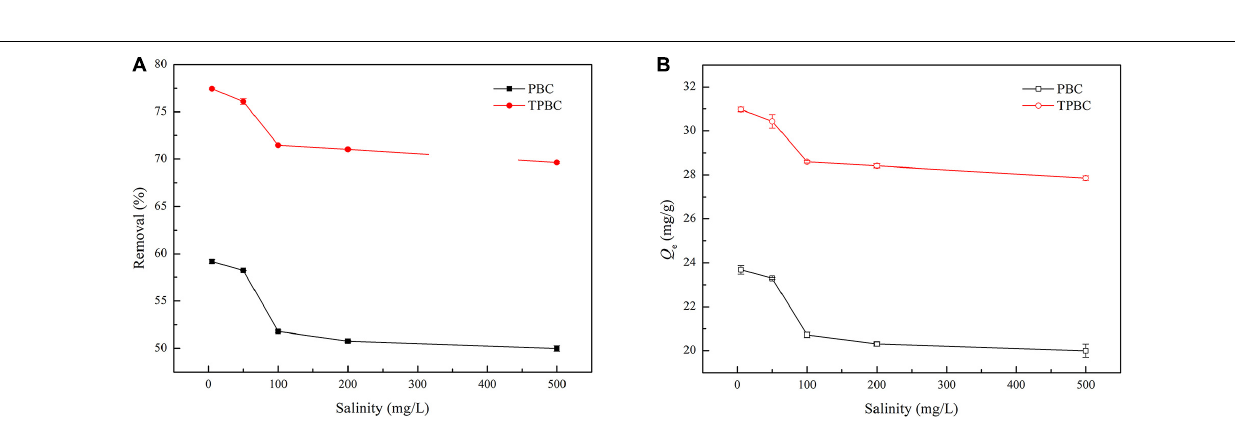
Frontiers in Energy Research |